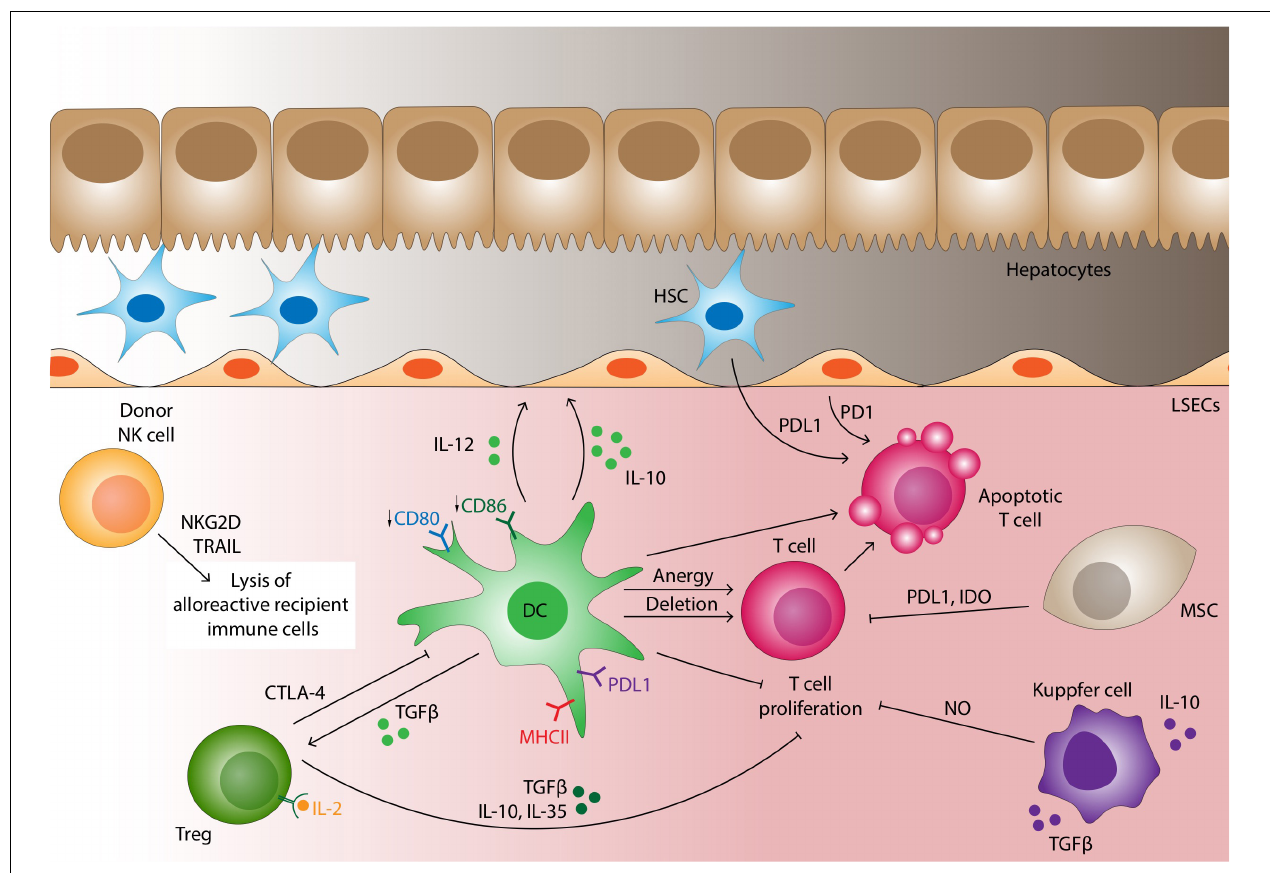
FIGURE 4 | Cellular mechanisms of liver allograft tolerance. A number of cells are able to promote tolerance in the liver allograft. Under normal non-inflamed conditions dendritic cells express low level of co-stimulatory molecules which along with the high expression of PDL1 induces T-cell anergy or deletion of the alloreactive T-cell clone. DCs also promote tolerance by secreting IL-10 and TGF- β which induces the differentiation of Tregs. CTLA4 on Tregs surface binds B7 on DC with a higher affinity than CD28, impairing DC-T-cell interactions. Tregs also contribute to the tolerogenic microenvironment also secreting TGF- β , IL-10 and IL-35, binding IL-2 on CD25 with higher affinity then T effector cells and by direct cytotoxicity through granzyme, perforin and Fas-FasL pathway. In contrast to recipient derived NK cells which tend to mediate rejection, donor derived NK cells transplanted as passenger cells within the liver allograft are able to directly lyse alloreactive recipient immune cells via NKG2D-MIC-A and TRAIL-TRAILR interactions leading to caspase-induced cell death. Mesenchymal stromal cells (MSCs) suppress T-cell proliferation and differentiation through the IDO pathway and cell-cell contact mediated by PDL1. Kupffer cells may be polarized to the M2 phenotype producing IL-10 and TGF- β and thus promoting tolerance. They can also release NO if stimulated by IFN- γ to inhibit T-cell proliferation. LSEC acts as non-professional antigen presenting cells with generally low levels of MHC class II expression; under many conditions induces antigen-specific tolerance. LSEC along with hepatic stellate cells induce T-cell apoptosis through PDL1/PD1 pathway interactions.